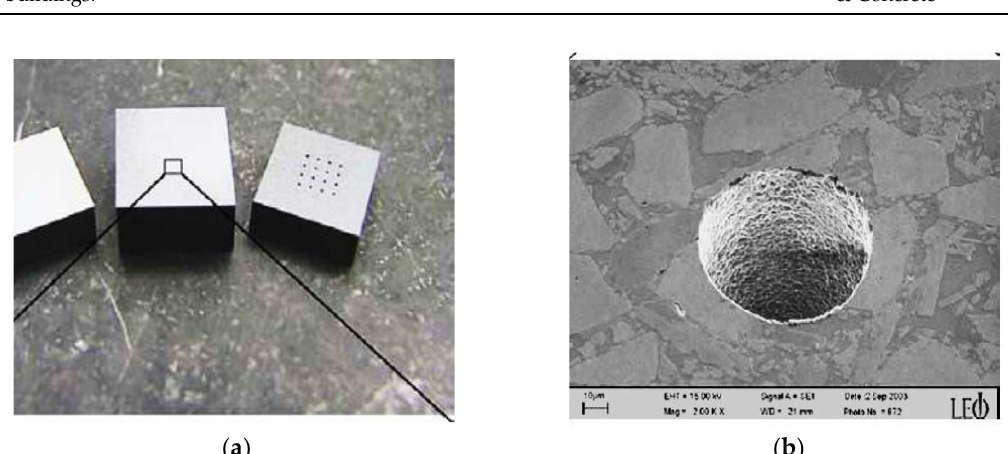
Figure 2. ( a ) Array of micro-holes in ceramic plates, ( b ) minimum hole diameter d min = 80 µm in electrically conductive Si 3 N 4 . (Reproduced with permission from [51]).